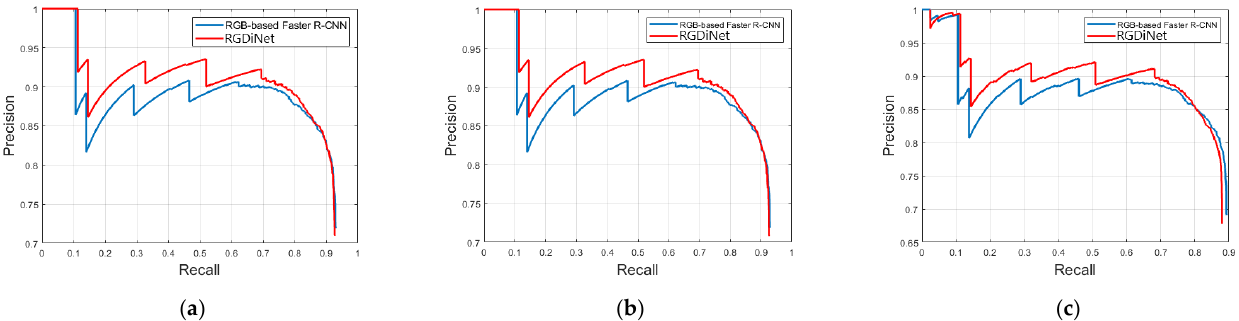
Figure 8. AP comparison of vision-based faster R-CNN and RGDiNet with varying IoUs: ( a ) IoU = 0.3 ( b ) IoU = 0.5 ( c ) IoU = 0.7.